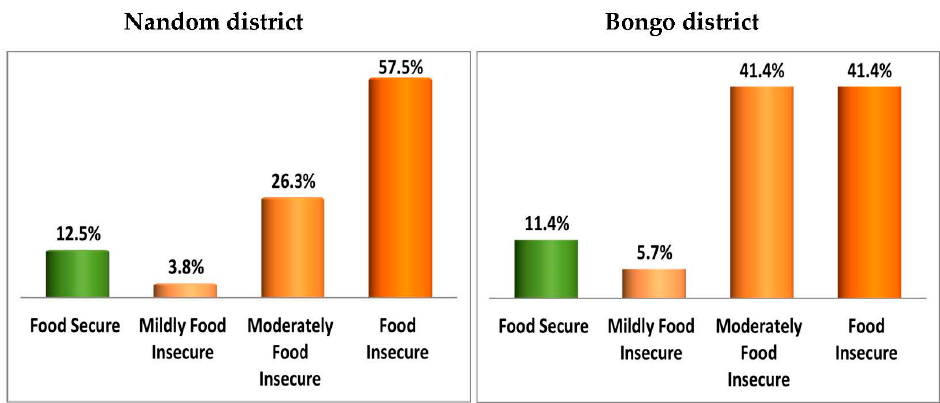
Figure 5. Household food insecurity access prevalence (HFIAP) in the districts.